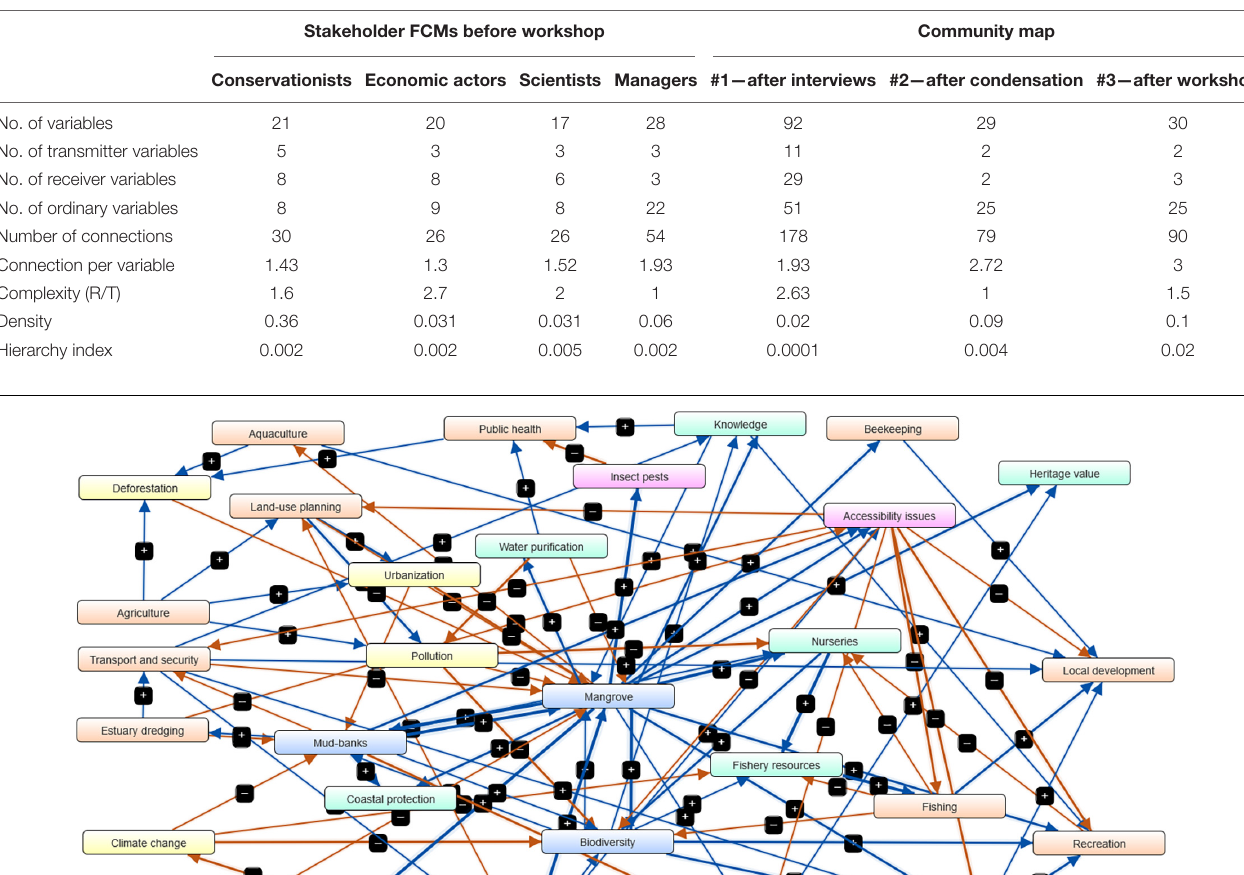
TABLE 3 | Graph theory indices of social maps obtained at different stage of the consultation process. Stakeholder FCMs before workshop Community map